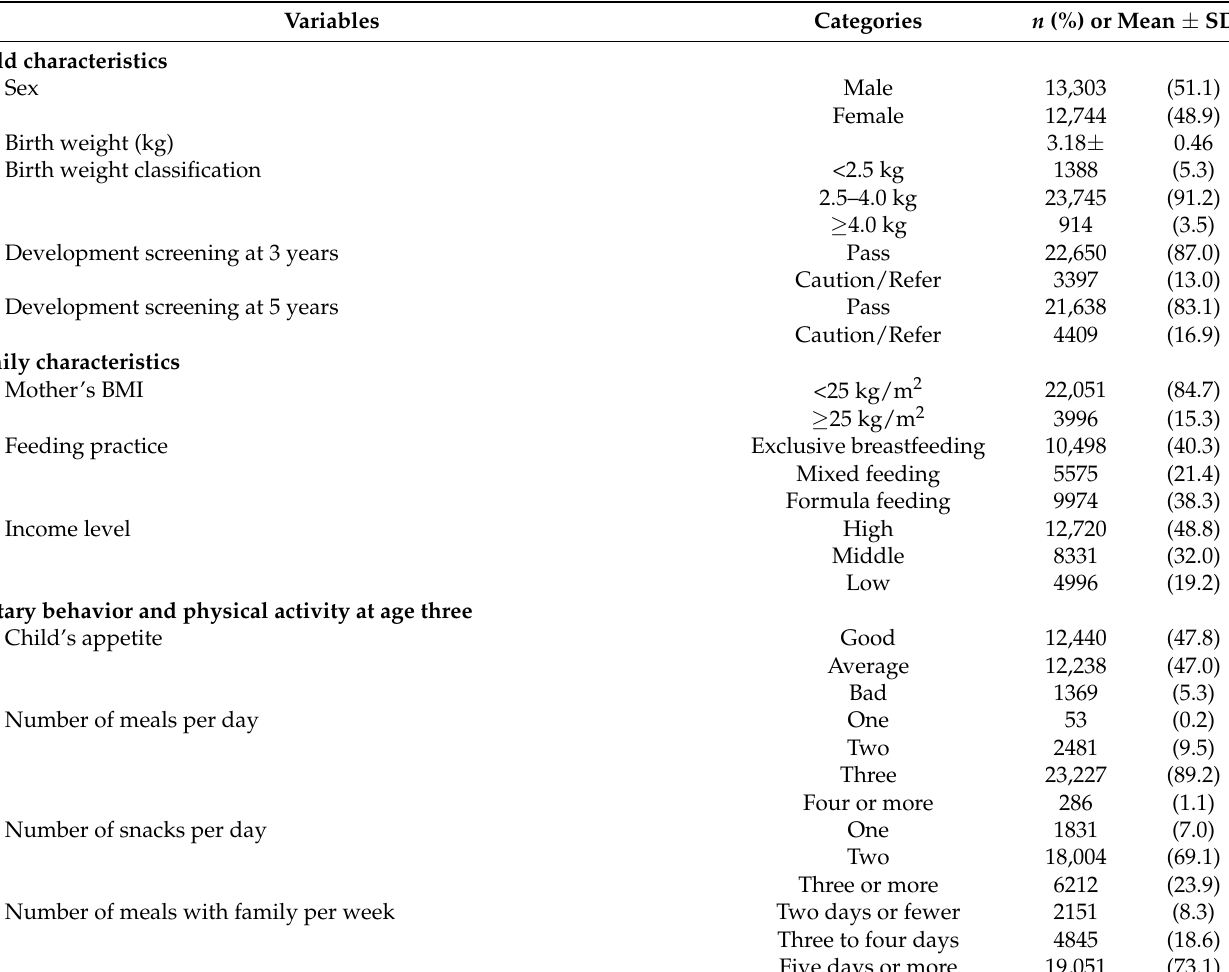
Table 1. Subjects’ characteristics ( n =